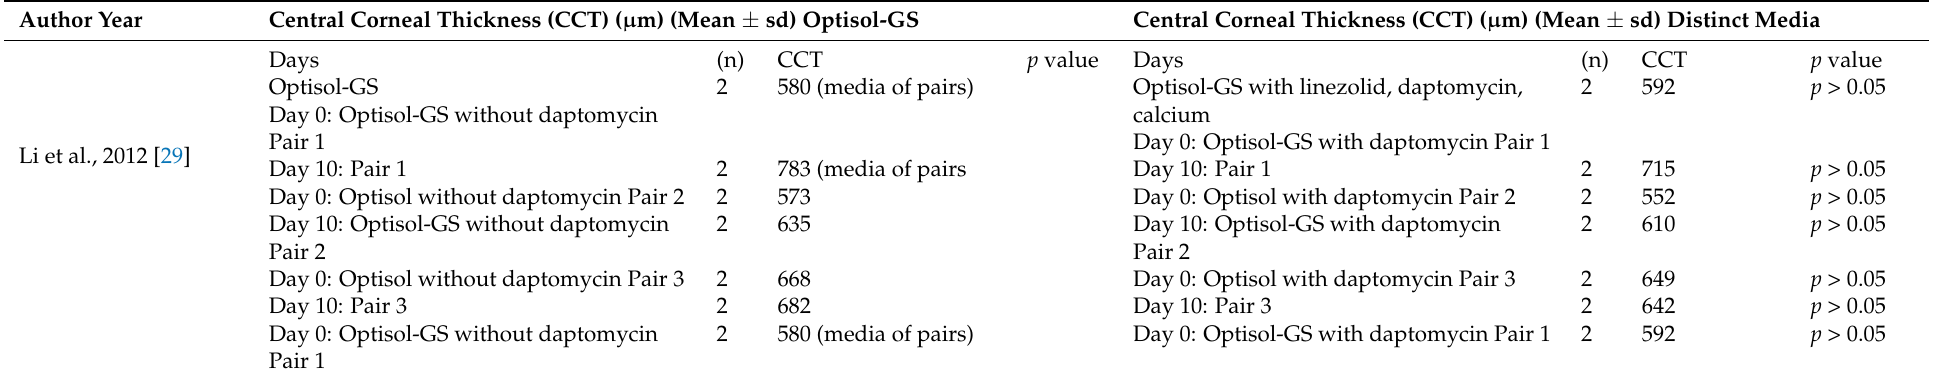
Table 8. Extracted results for central corneal thickness